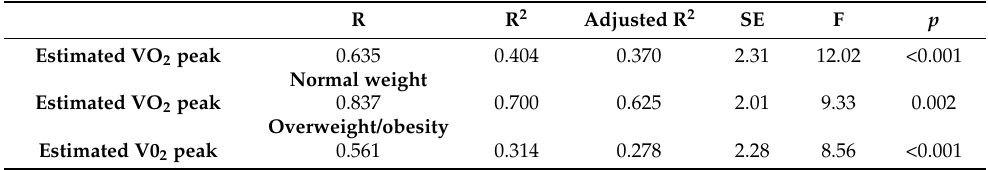
Table 3. Summary of the multivariate linear regression models of 5-STS.